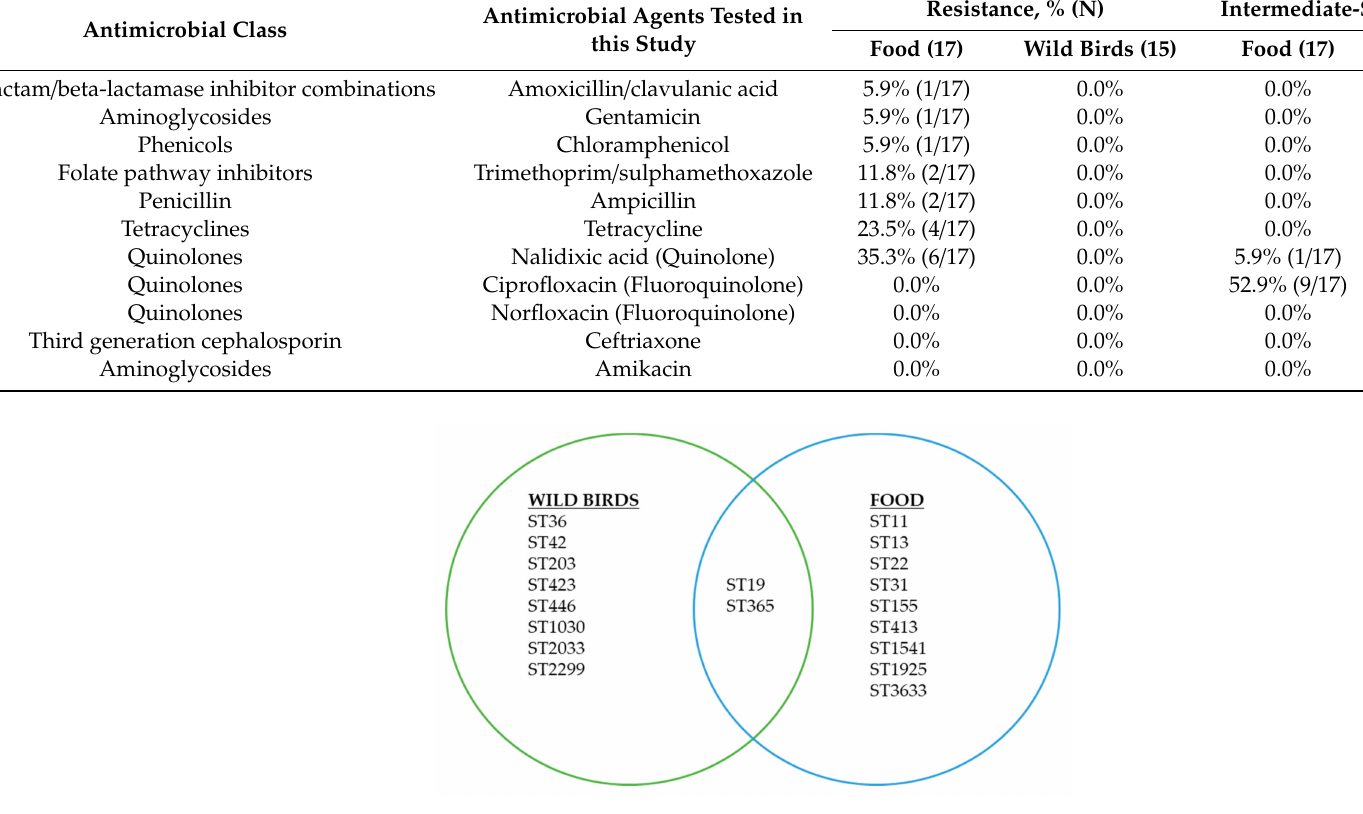
Figure 1. Sequence types and cross sectorial distributions of Salmonella isolates in food and wild birds found in this